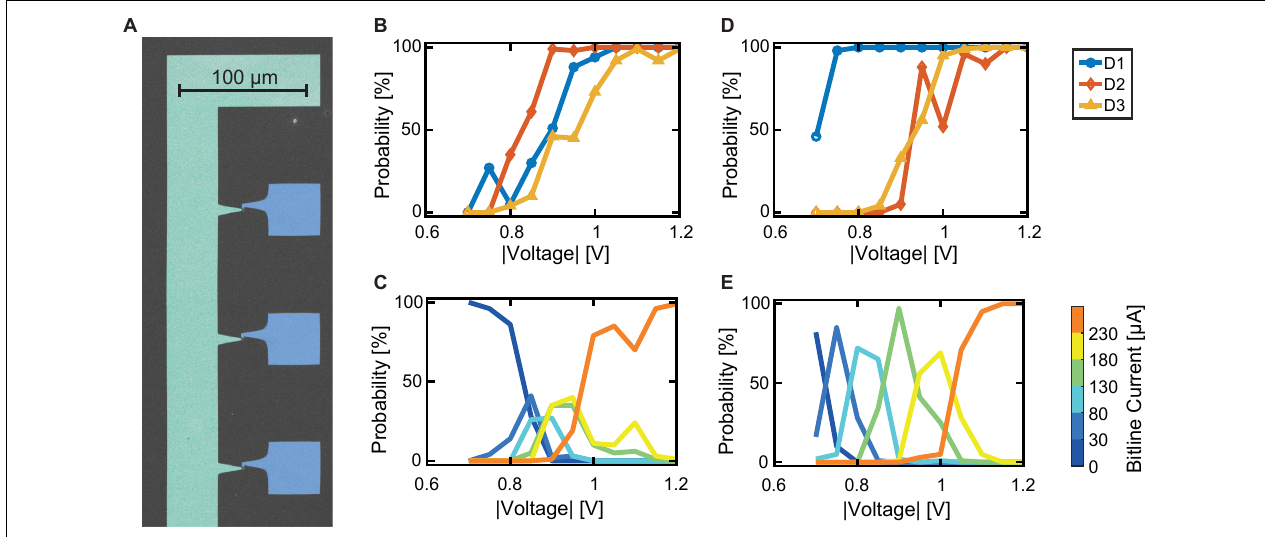
FIGURE 7 | Experimental demonstration of favorable synapse characteristics. (A) SEM picture of a section of the device structure contacted in a probe card arrangement. Blue: Top electrodes. Green: Bitline electrode (color added in post-processing). (B) SET probability traces of three similar devices. (C) Resulting bitline current probabilities, showing the narrow voltage range for tunability. (D) SET probability traces of three significantly different devices. (E) Resulting separated bitline current ranges.